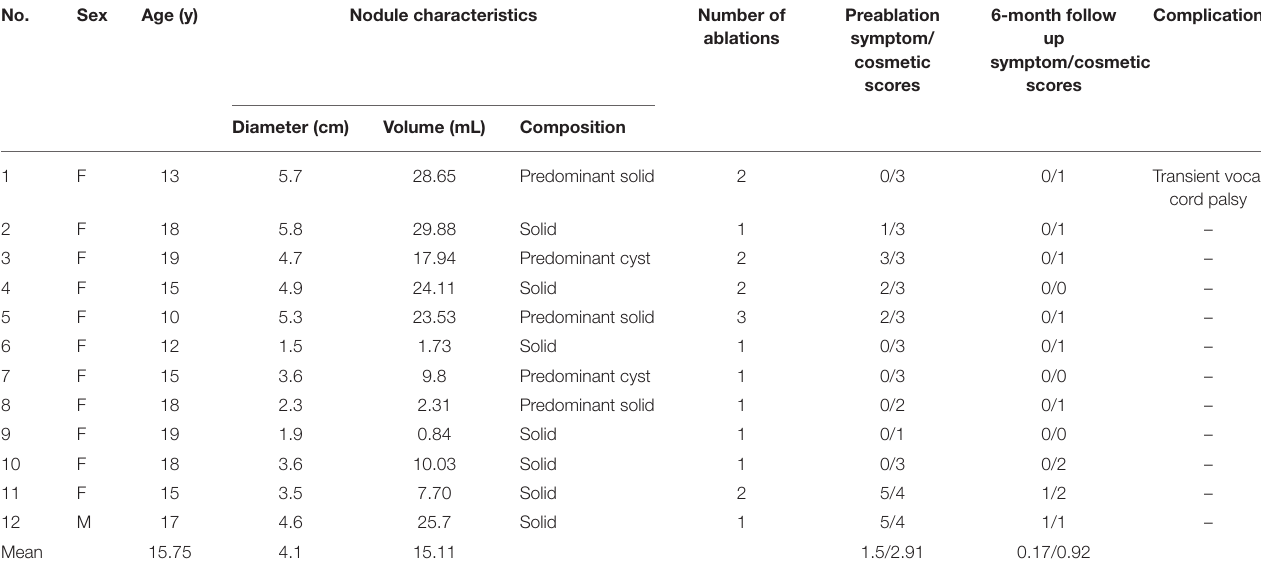
TABLE 1 | Profile of pediatric patients with benign thyroid nodules who underwent RFA. No. Sex Age (y) Nodule characteristics